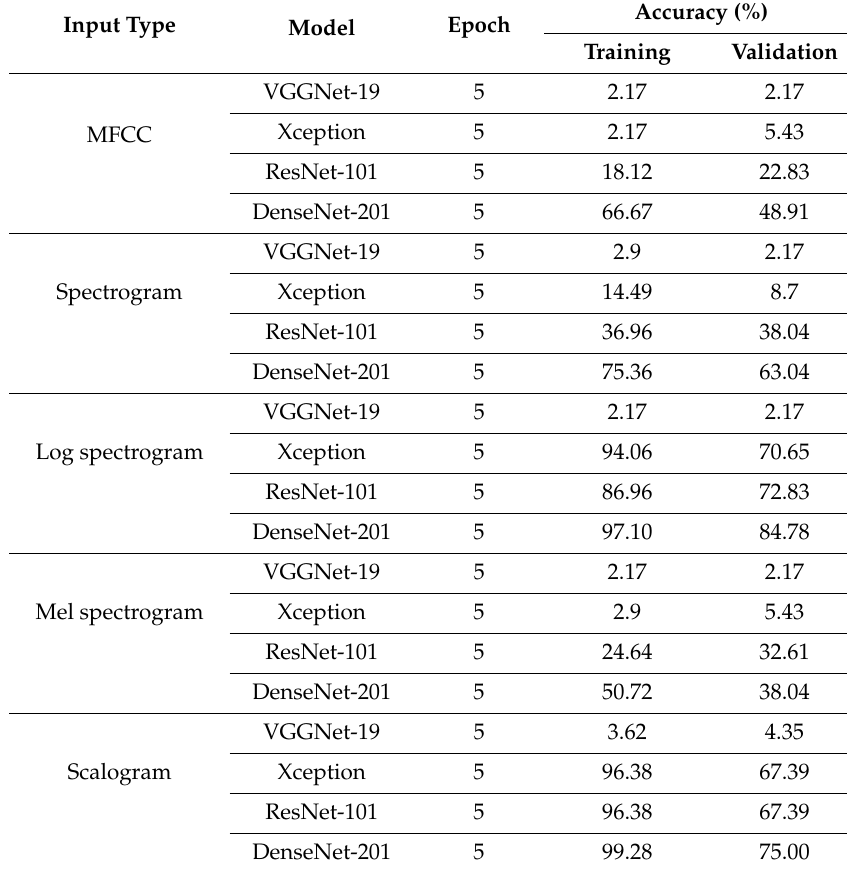
Table 9. Accuracies achieved by various models based on the CNN using di ff erent time-frequency representations on